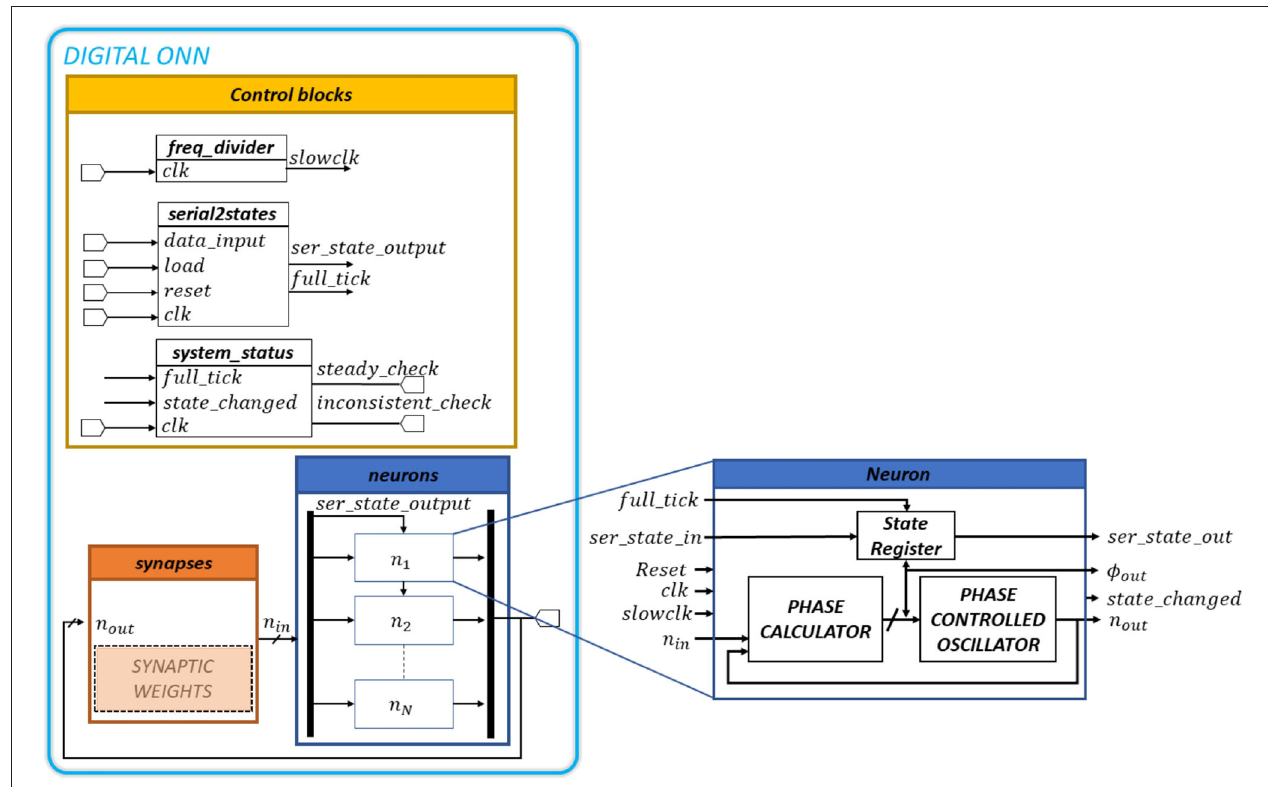
FIGURE 3 | Complete digital ONN design representing digital blocks and block description with the operating principle of a single oscillatory